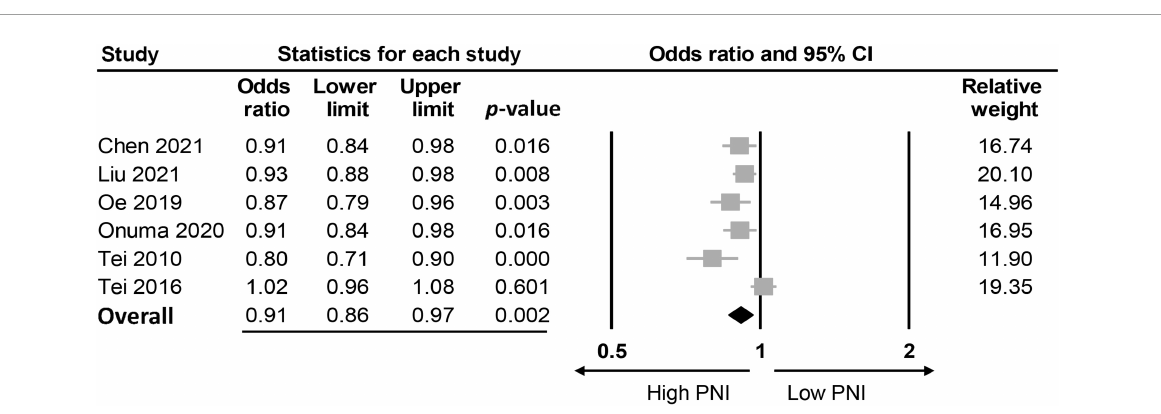
FIGURE4 Forest plot demonstrating a negative correlation between risk of postoperative delirium (POD) and prognostic nutritional index (PNI) (OR: 0.91, 95% CI: 0.86–0.97, p = 0.002, I 2 = 71%). CI, confidence interval.